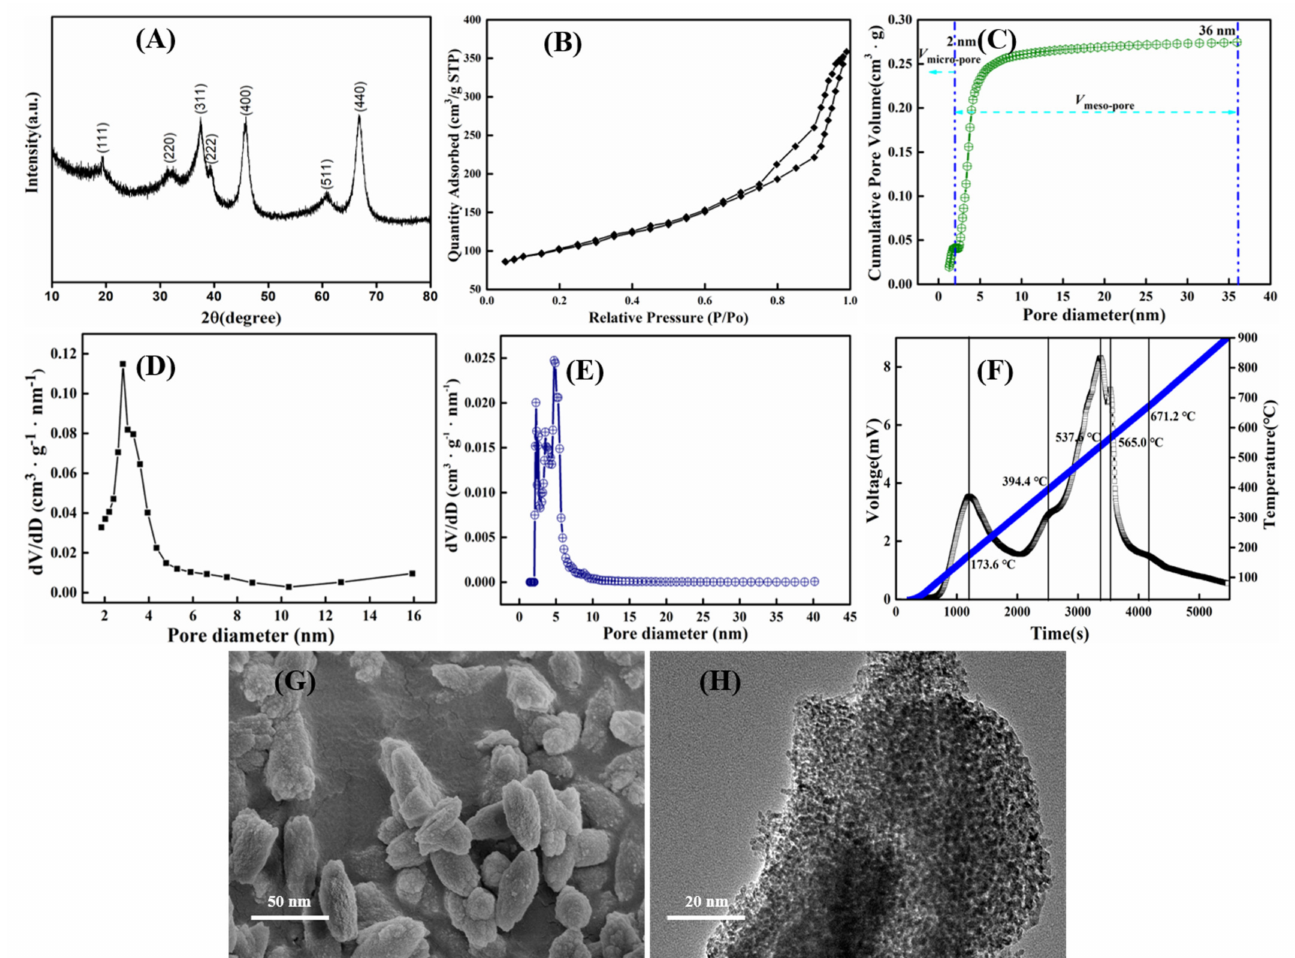
Figure 6. ( A ) XRD pattern; ( B ) nitrogen adsorption–desorption isotherm and pore-size distribution curve; ( C ) determi- nation of pore volume obtained by NLDFT; ( D , E ) pore-size distribution curves through BJH model and NLDFT kernel; ( F ) CO 2 -TPD profile; ( G ) SEM image; ( H ) TEM image of γ -Al 2 O 3 materials synthesized at pH = 10 by calcining precipitation of sodium aluminate and hydrochloric acid at 500 ◦